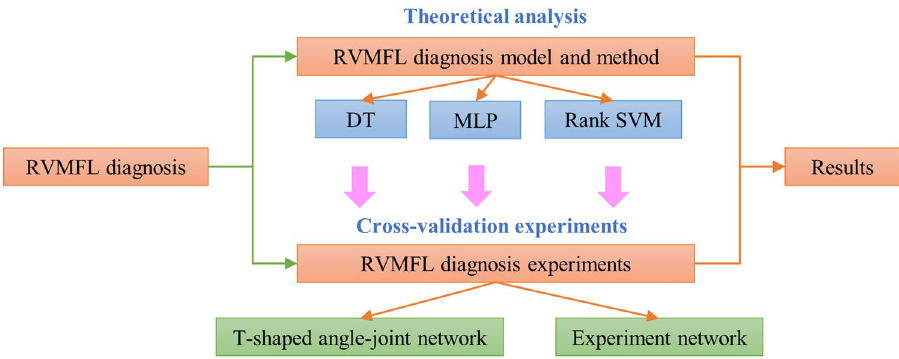
Figure 1. Research